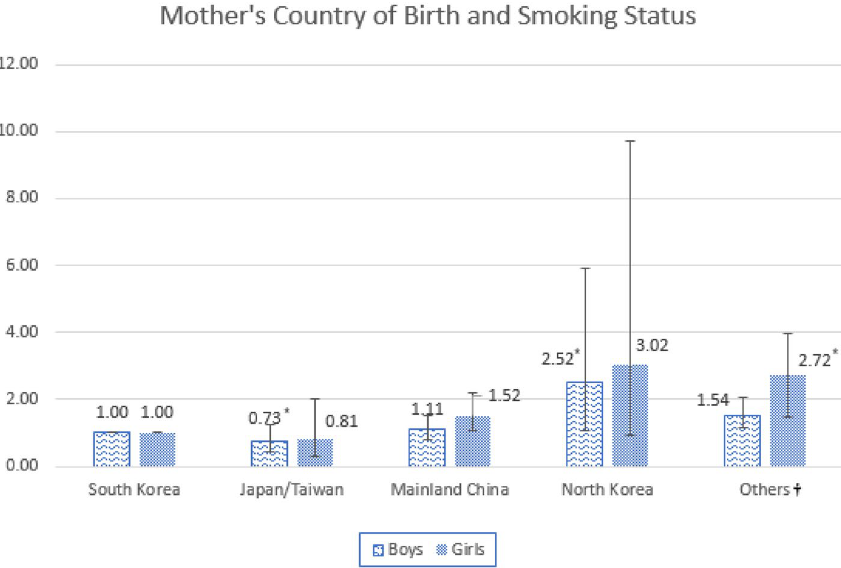
Figure 2. Subgroup analysis of the association between Mother’s Country of Birth and Smoking Status. *P < 0.05, **P < 0.01, ***P < 0.001. † Countries including Vietnam, Philippines, Mongolia, Thailand, Cambodia, Russia and